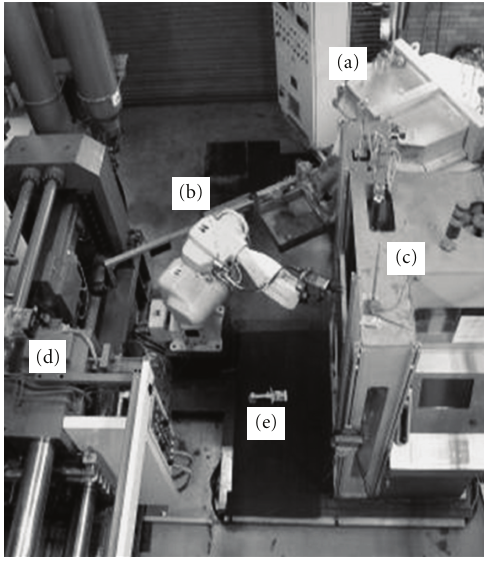
Figure 2: The CSIR-RCS-HPDC cell arrangement: automatic dosing furnace with controller (a), automated robotic arm (b), the CSIR-RCS processing unit (c), shot end of the 630 ton HPDC machine (d), and a brake caliper casting for scale (e).